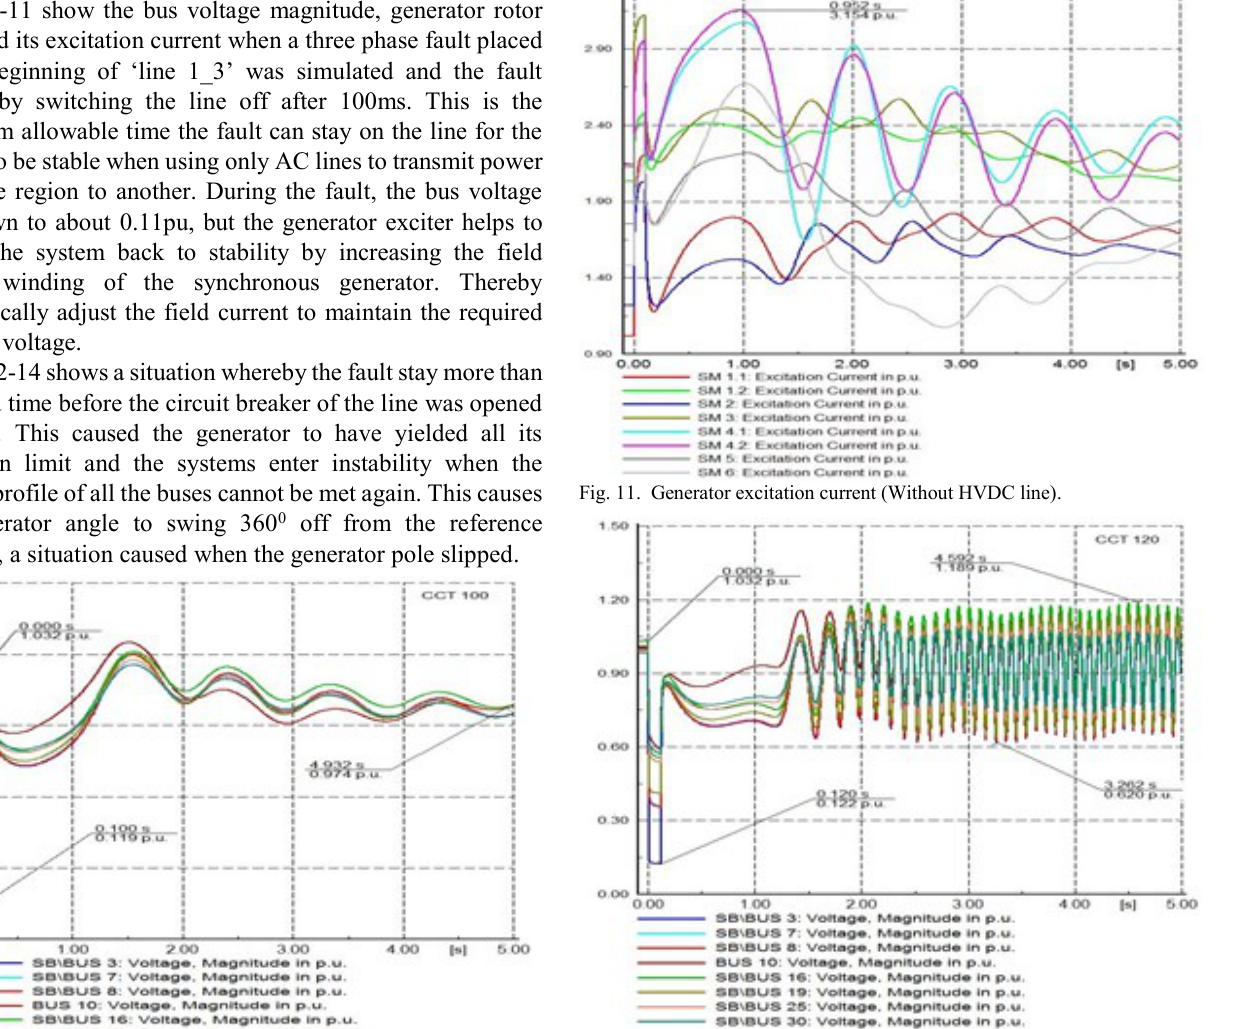
Fig. 12. Voltage Plot during fault on ‘Line 1_3’, cleared by switching off the line after 120ms. (Without HVDC line)